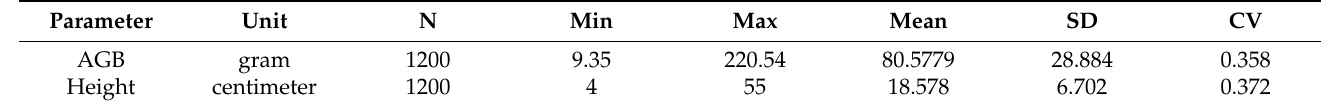
Table 1. Statistical analysis of AGB and grass height data.